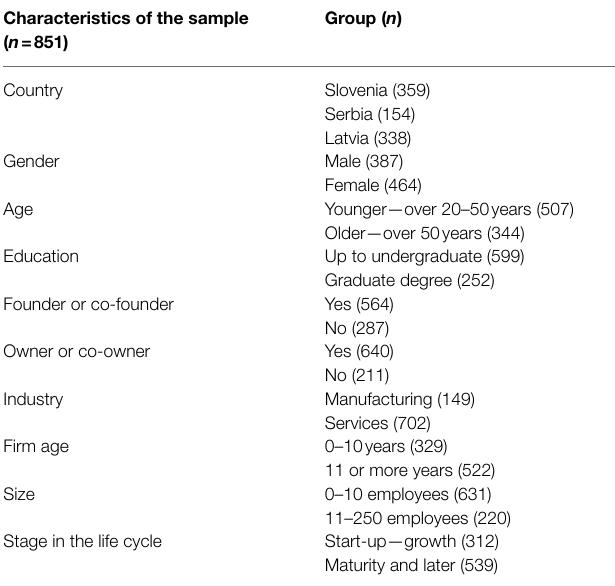
TABLE 1 | Characteristics of the